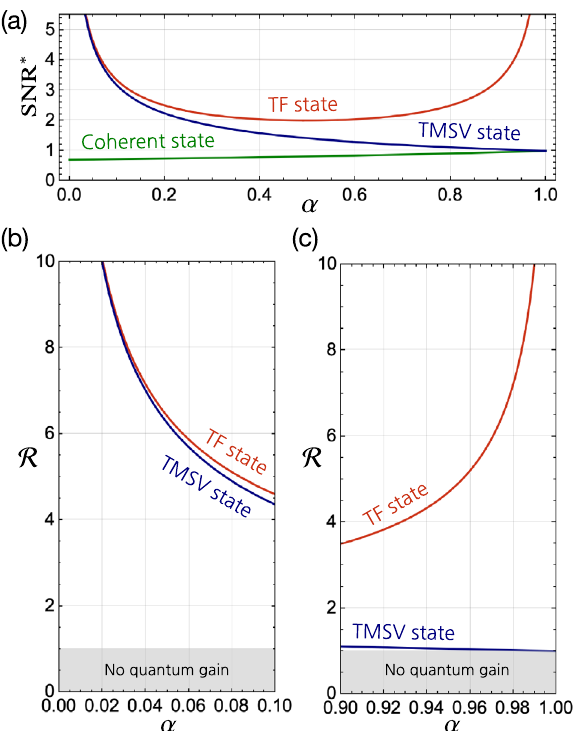
Figure 4. ( a ) The SNR ∗ s obtainable when probing the analyze with a coherent state, the TF state, and the TMSV state as a function of the sample absorption α . The quantum gain R of the SNR ∗ with respect to the benchmark SNR ∗ coh is elaborated on two particular regimes: ( b ) small α and ( c ) large α . Here, δα c 10 6 (i.e., N eff 1 ) are considered as an and ¯ = =